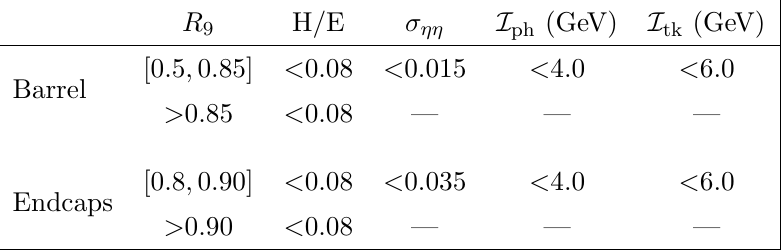
Table 1 . Schema of the photon preselection requirements. Preselection category